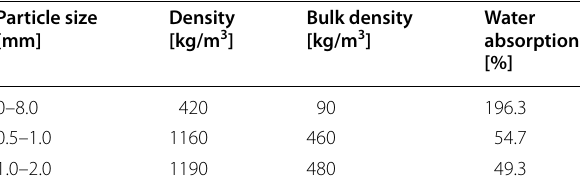
Table 4 Properties of the primary and secondary spruce chips